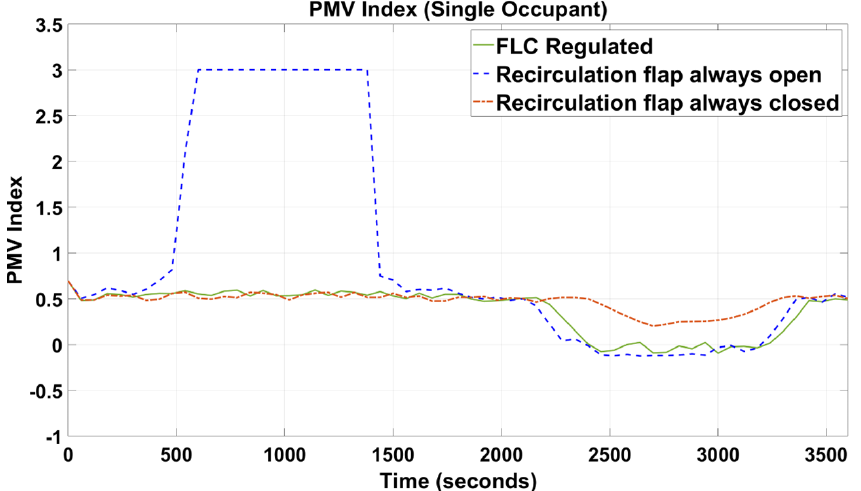
Figure 5. PMV index of the simulated vehicle cabin with one occupant.